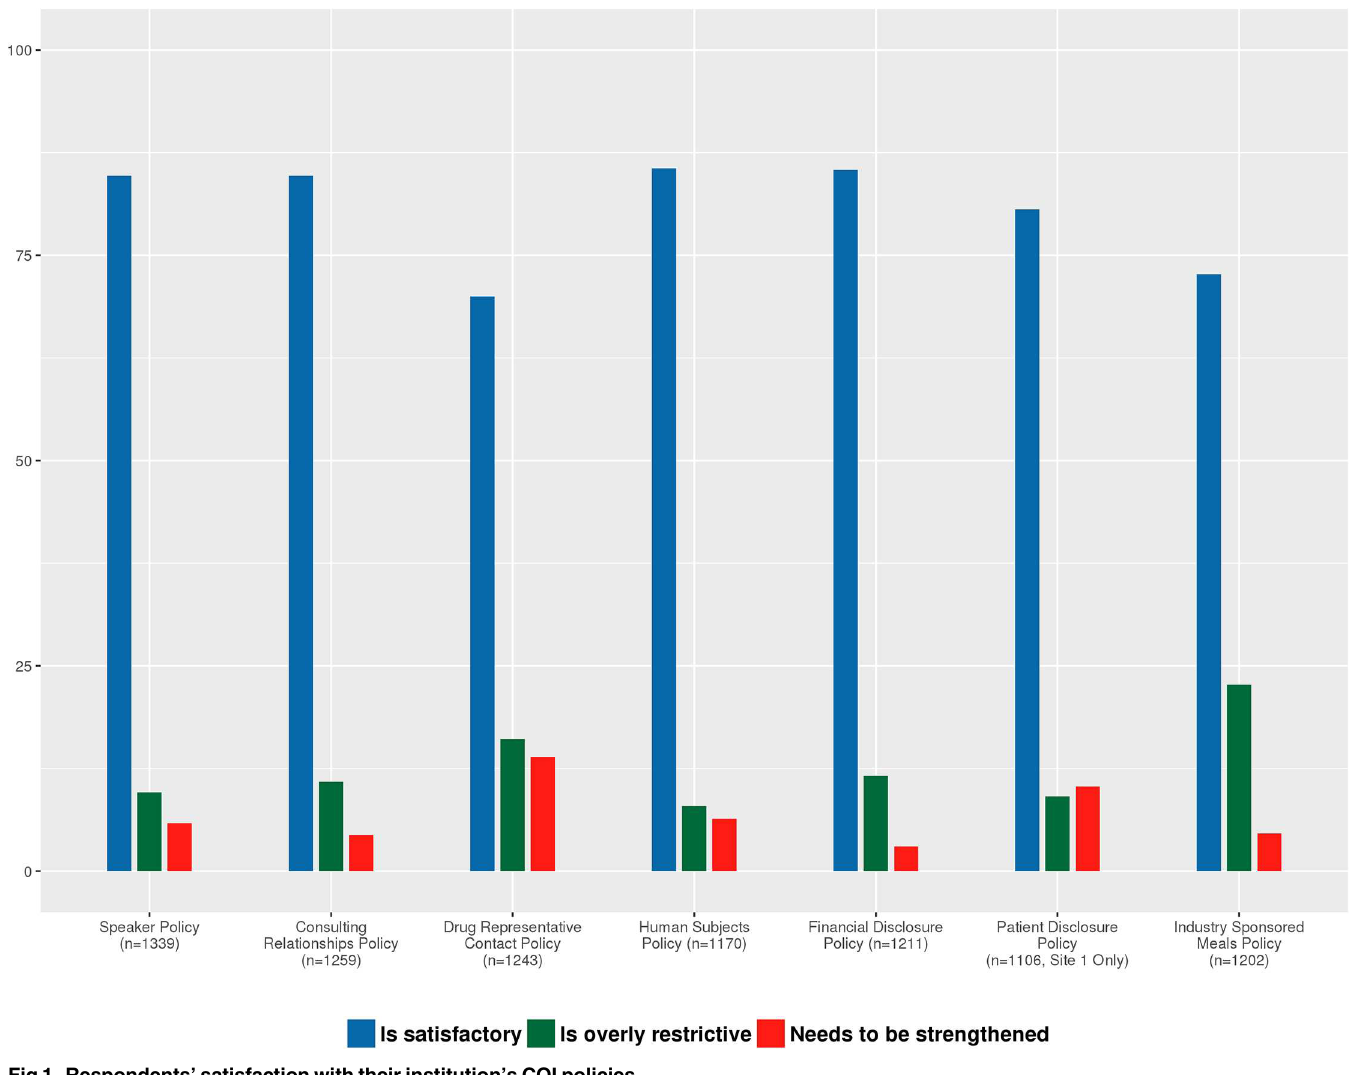
Fig 1. Respondents’ satisfaction with their institution’s COI policies.